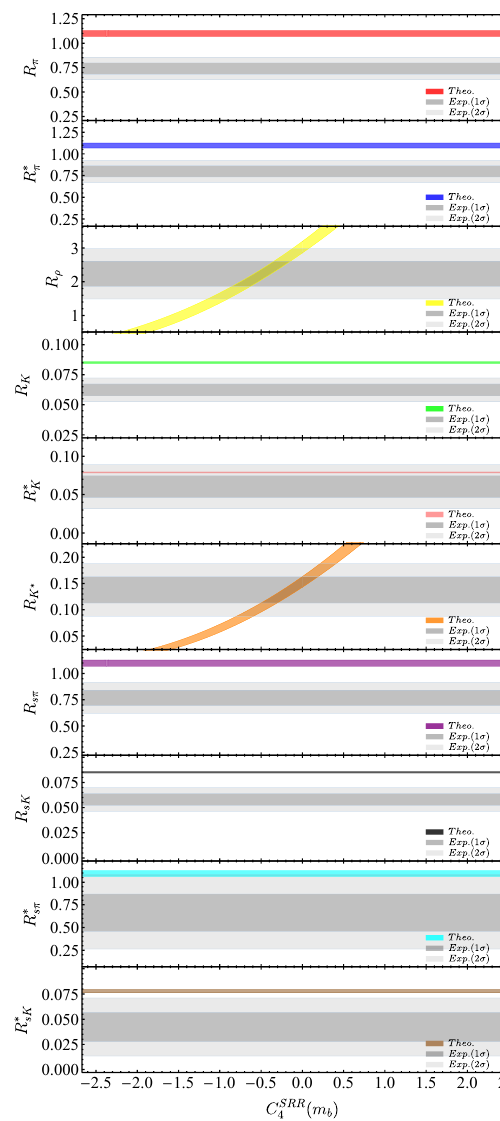
( m b ) (left) and C SRR